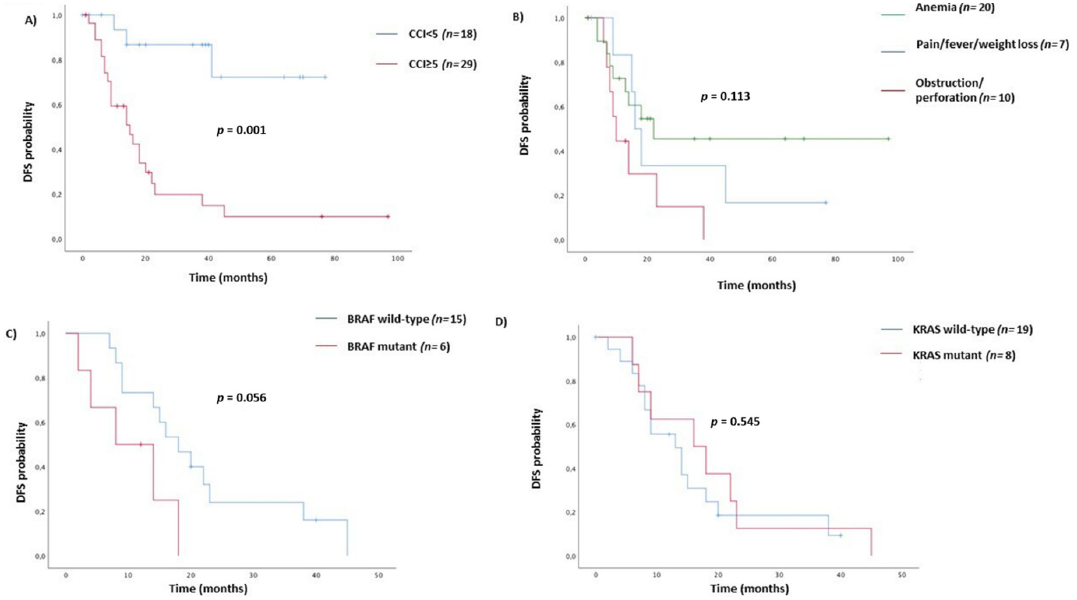
Figure 1. Kaplan–Meier curves for DFS according to Charlson Comorbidity Index ( A ), clinical onset ( B ), BRAF status ( C ), and KRAS status ( D ).